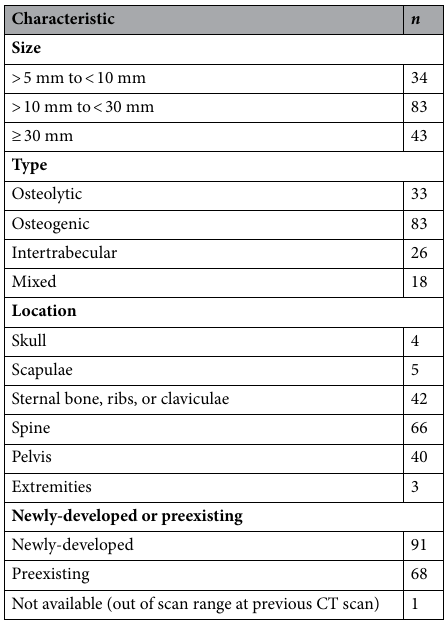
Table.2. Lesion characteristics. CT computed